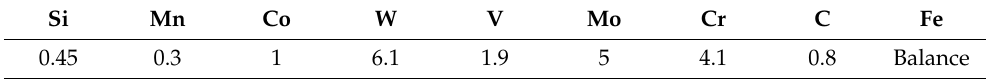
Table 1. Chemical composition (wt.%) of AISI-M2 high-speed steel